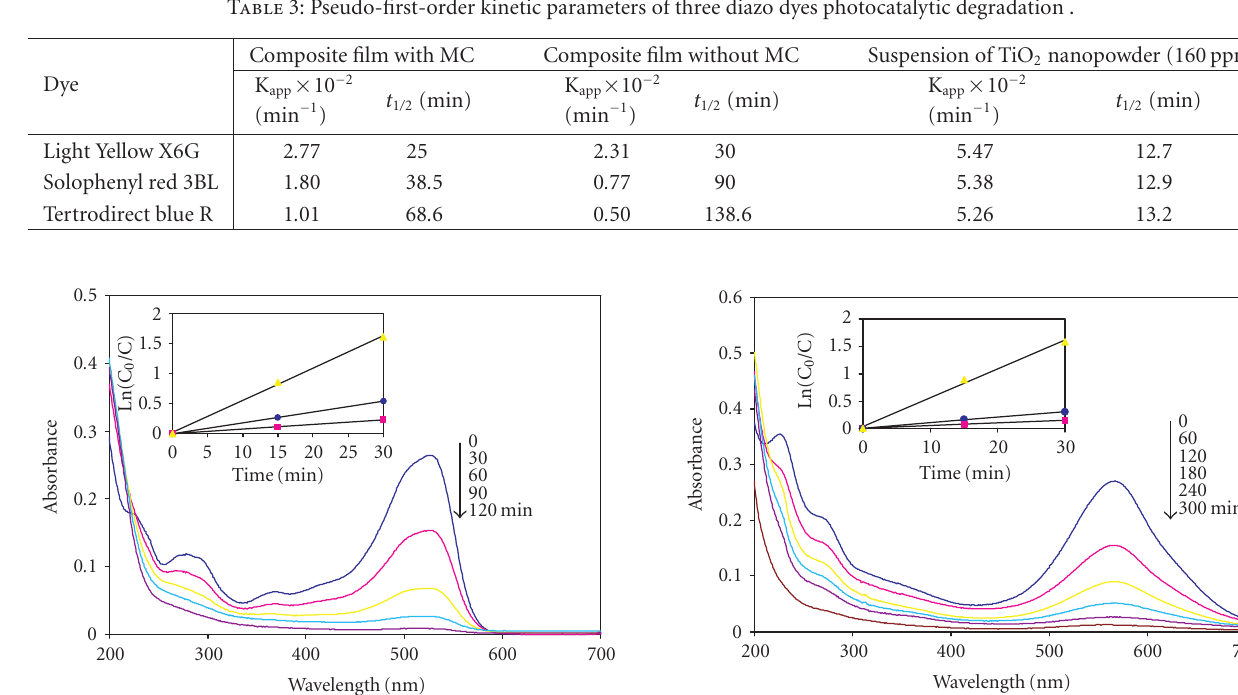
Figure 7: Time-dependent UV-Vis spectrum of 3BL solution dur- ing photoirradation on one piece of composite TiO 2 with MC, pH 6 . 00, dye concentration, 10ppm. The inset of the figure shows the kinetic data for this dye in the presence of slurry nanopowder TiO 2 (160ppm) solution ( (cid:2) ) composite thick film without MC ( (cid:2) ), and composite thick film with MC ( • ).